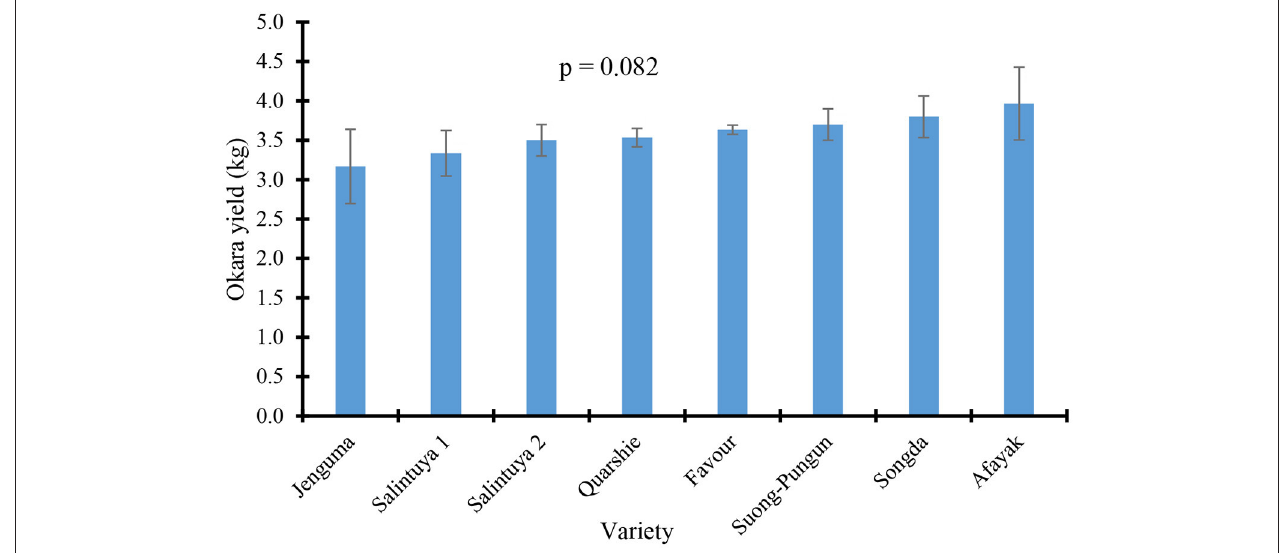
FIGURE 6 | Water absorption capacity (A) , Bulk density (B) , Swelling capacity (C) , and pH (D) of okara-enriched cassava grits. Values are means ± SD; n = 3. Data points with the same letters are not significantly different after ANOVA and means compared using LSD test ( p > 0.05). Average pH of fresh okara = 6.3.